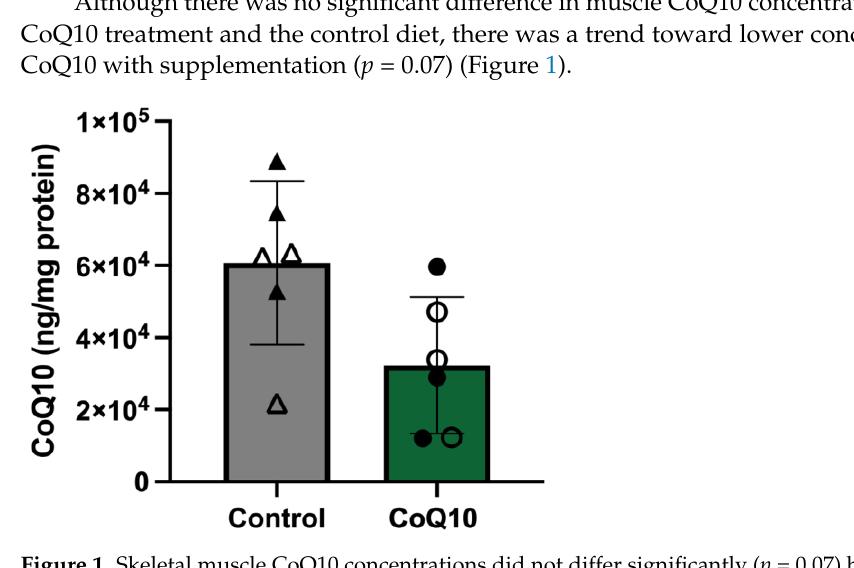
Figure 1. Skeletal muscle CoQ10 concentrations did not differ significantly ( p = 0.07) between control and CoQ10 treatments. Open circles represent horses on the CoQ10 supplement during the first supplementation period, and closed circles represent horses on the CoQ10 supplement during the second supplementation period. Open triangles represent horses on the control diet during the second supplementation period, and closed triangles represent horses on the control diet during the first supplementation period.